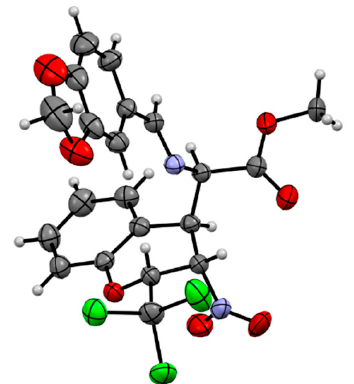
Figure 6. Molecular structure of 10c (ORTEP drawing, 30% probability level).